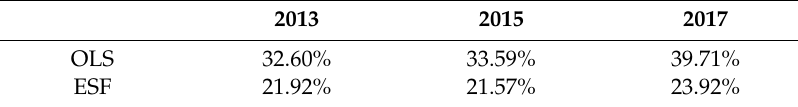
Table 12. LOOCV MARE of the OLS and ESF regression